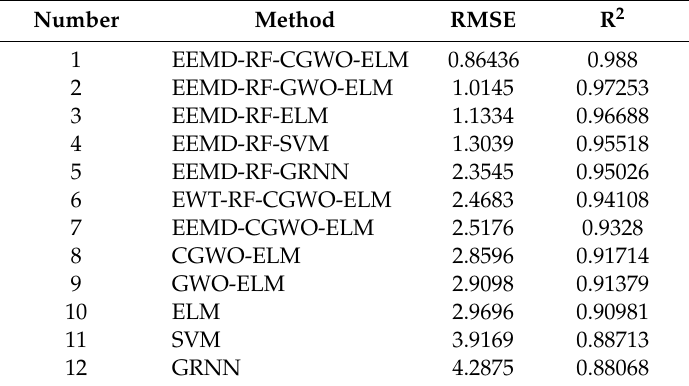
Figure 14. Comparison of 12 prediction results of “Yangdong Line.” Table 4. Prediction method error analysis table of “Yangdong